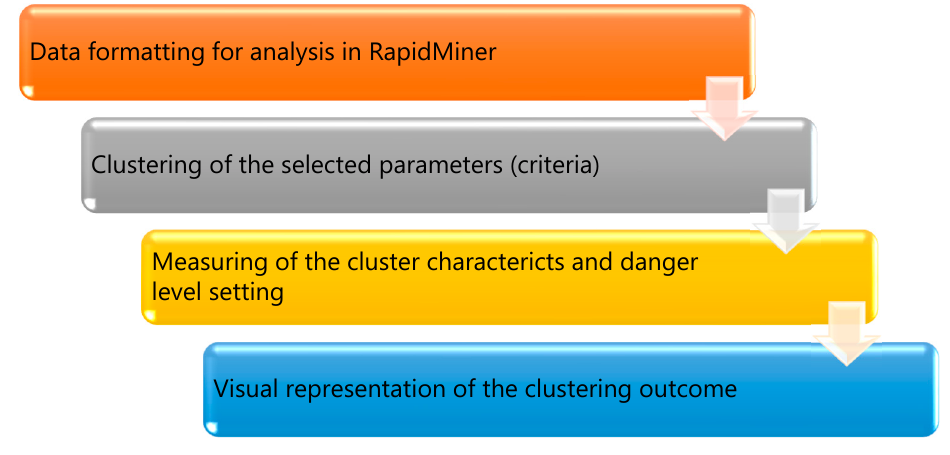
Figure 4. The main characteristics of the clustering subsystem.